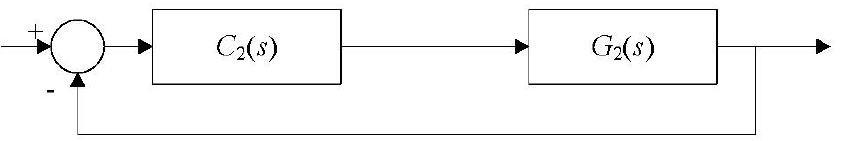
Figure 3. Block-diagram of the pitch angle controller for the wind turbine